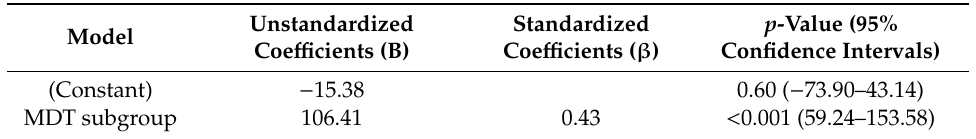
Table 2. Results of multiple regression modeling for the number of days until the discharge from the mechanical diagnosis and therapy (MDT).